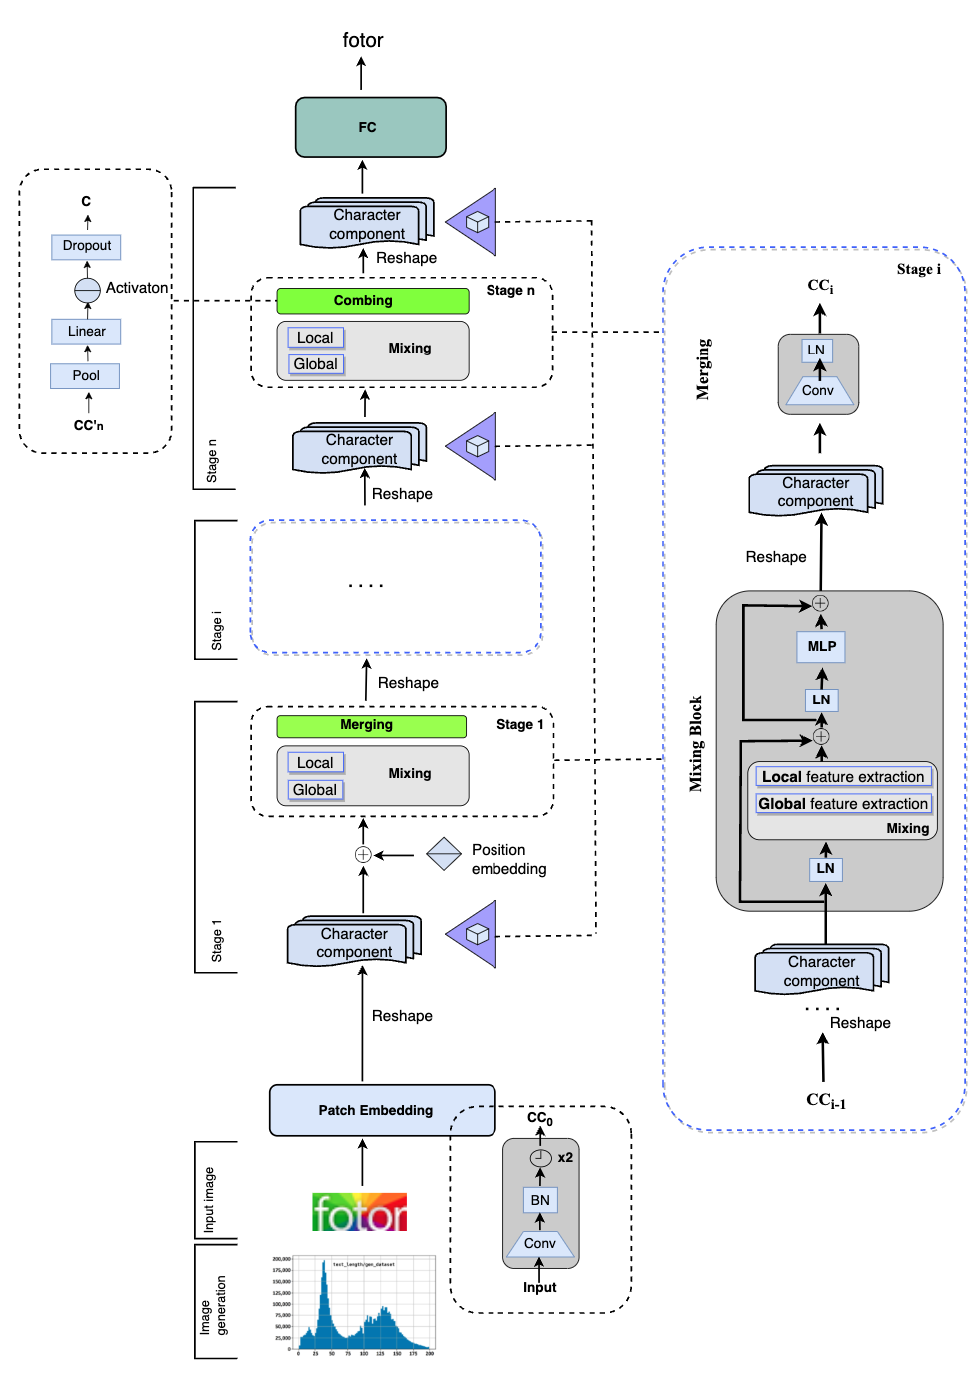
Figure 4. SVTR architecture, adapted from